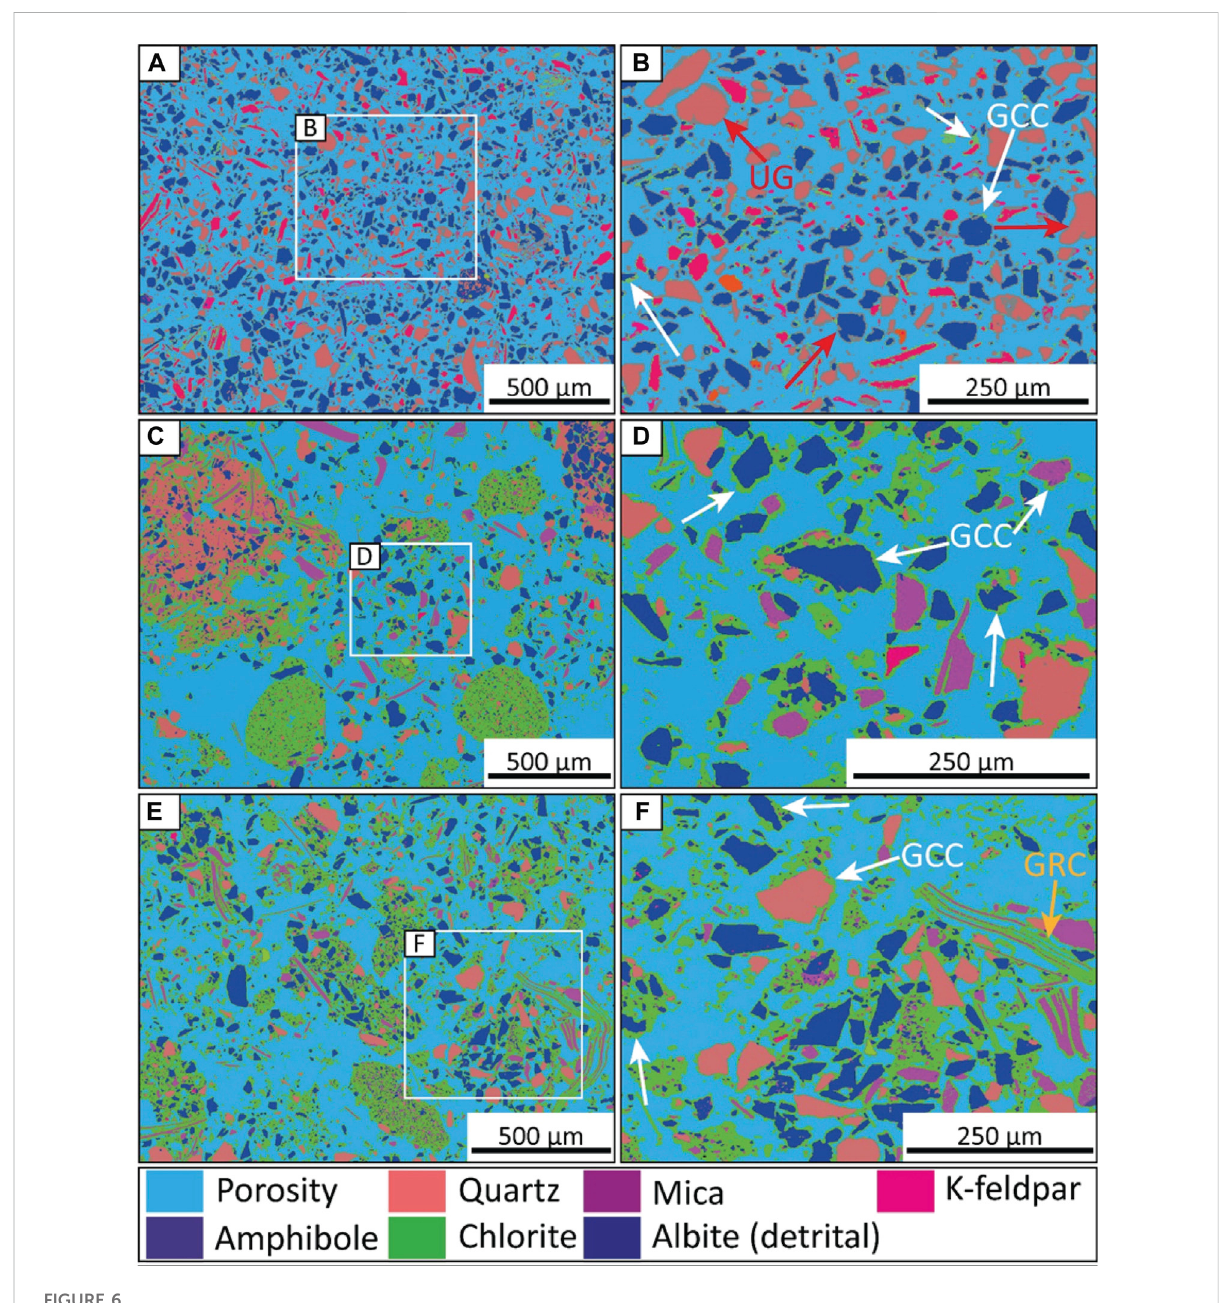
FIGURE 6 EDS mineral maps of the reacted and unreacted samples of Station 036. (A) Processed EDS mineralogical map of the unreacted, pre- experiment Sample 4 showing the distribution of framework minerals. (B) Zoomed-in EDS mineral map of the inset in (A) . Note the uncoated grains (UG;redarrows)andthegenerallackofgrain-coatingchlorite(GCC). (C) AnalysedEDSmineralmapofthereactedSample5showingthedistribution of framework and diagenetic minerals. (D) Zoomed-in EDS mineral map of the inset in (C) . Notice the well-developed grain-coating chlorite (GCC) on detrital grains. (E) EDS mineral map of the post-experiment Sample 6 showing the distribution of framework and diagenetic minerals. (F) Zoomed-in EDS mineral map of the inset in (E) . In this image, grain-coating chlorite (GCC) appear to be well-developed on detrital grains, and note the grain-replacive chlorite (GRC) replacing